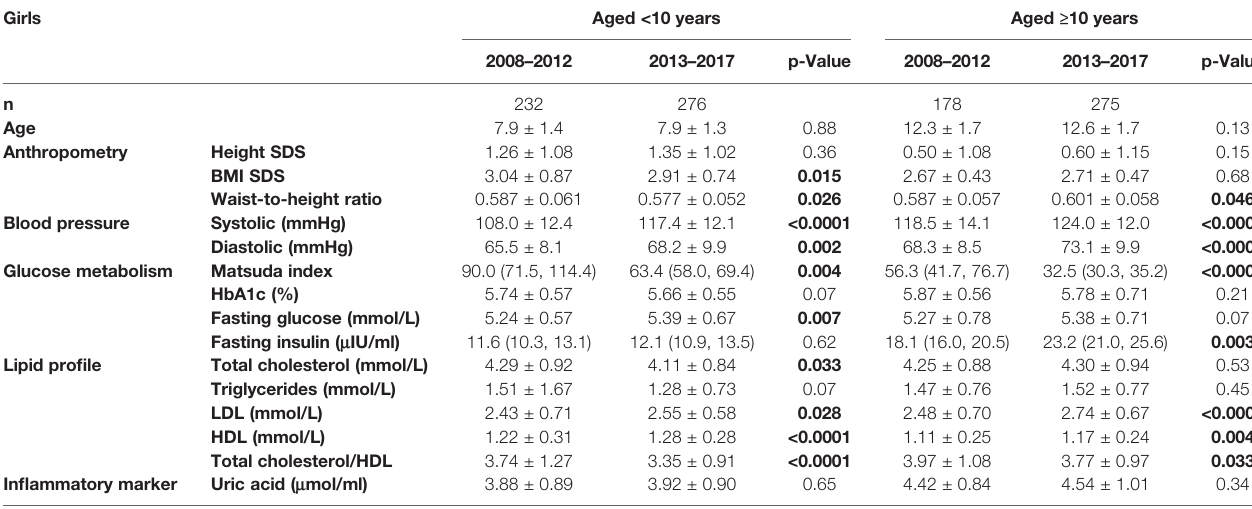
TABLE 7 | Cardiometabolic parameters among girls with obesity assessed between 2008 and 2017 in Hangzhou (Zhejiang Province, China).